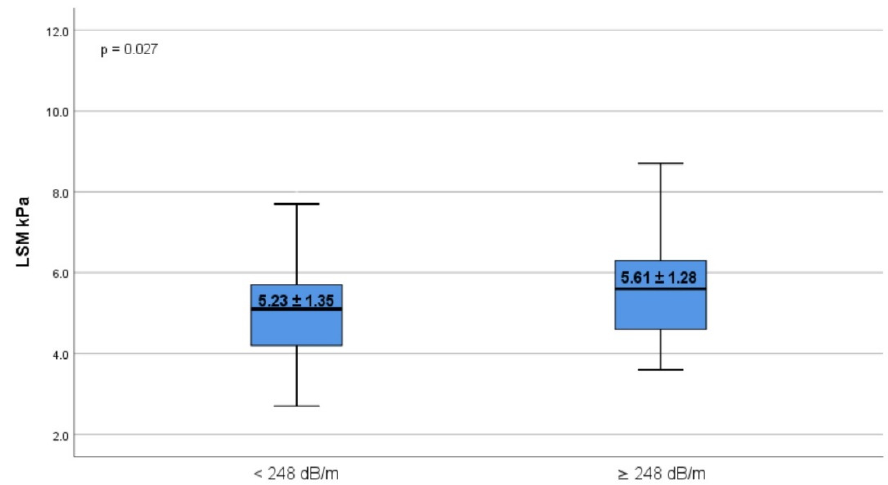
Figure 2 . Distribution of LSM values according to absence or presence of liver steatosis. The bottom and the top of each box represent the 25th and 75th percentiles, while the lines through the box indicate the median. The error bars indicate the 10th and 90th percentiles. LSM, liver stiffness measurement .